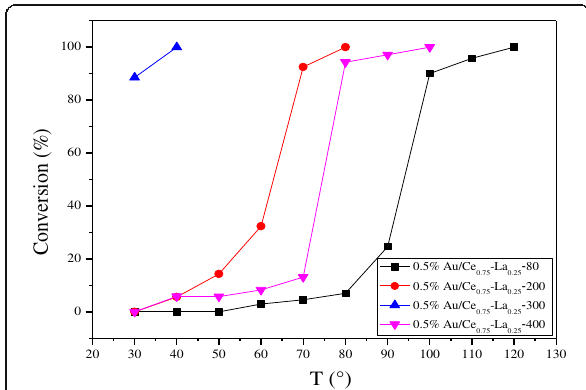
Fig. 11 Catalytic activities of 0.5% Au/Ce 0.75 -La 0.25 nanorods calcined at different temperatures